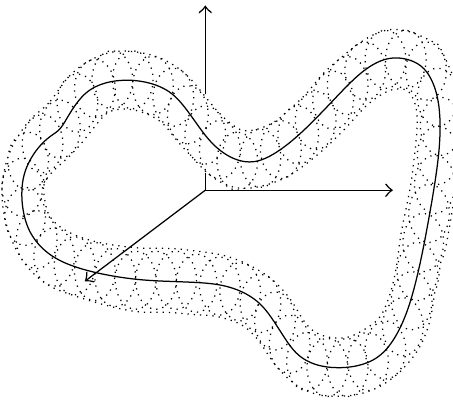
Figure 4.1. A radial distribution relative to a